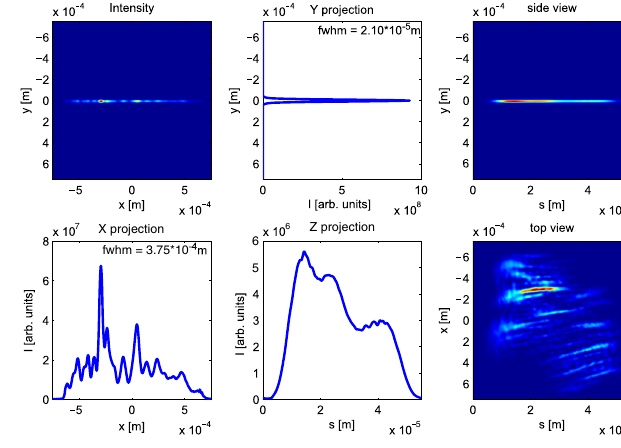
FIG. 9. Radiation distribution immediately after the grating in frequency domain.